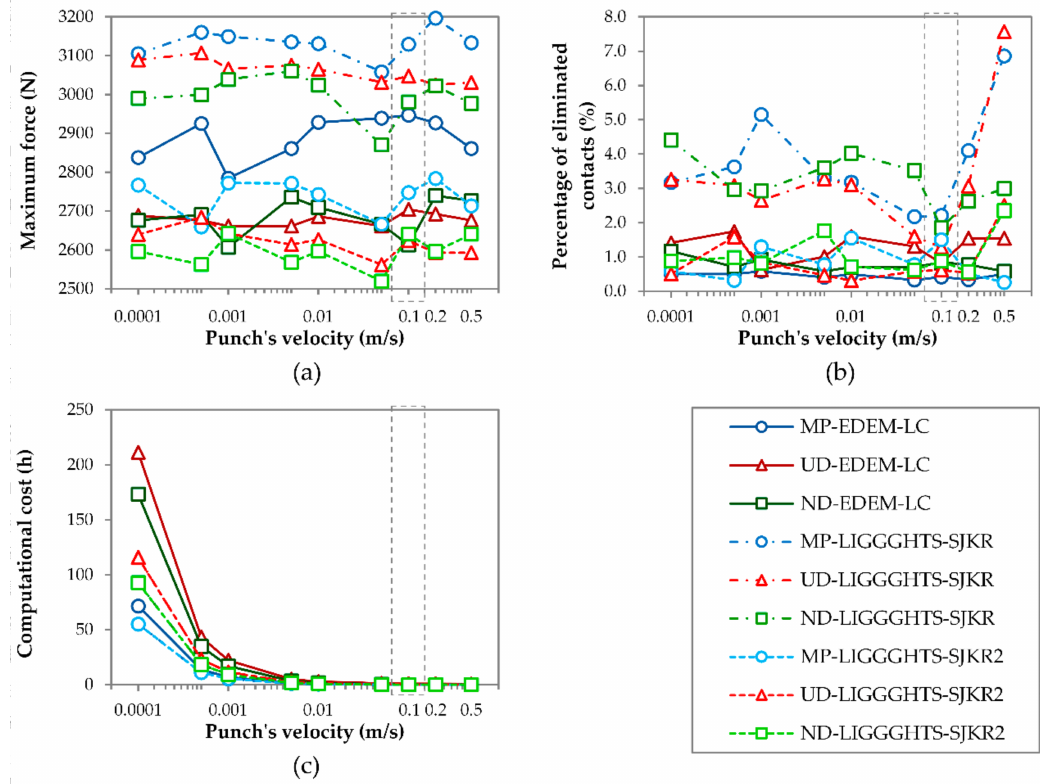
Figure 7. Effect of the speed of the punch on ( a ) the maximum force applied by the punch, ( b ) the percentage of eliminated contacts after removal of the matrix, and ( c ) the total computational